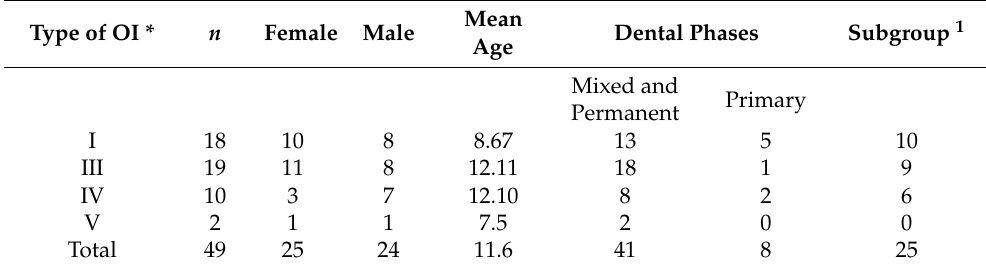
1 Sample subgroup: lateral teleradiography and tracings. * Osteogenesis